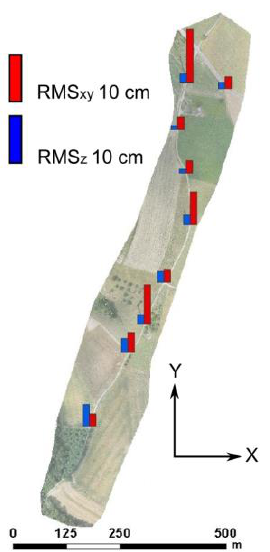
Table 6. Pix4D – summary of the position accuracy at 9 check points